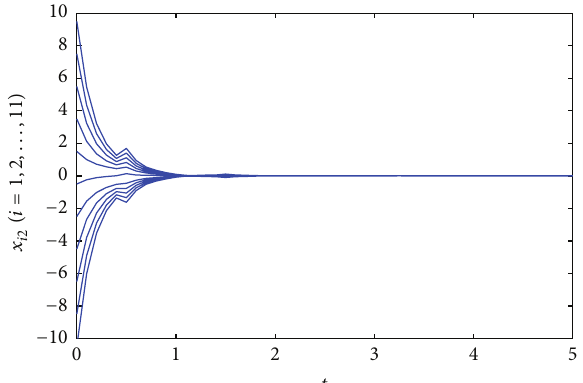
Figure 3: Time response of the state variable 𝑥 2 (𝑡) with impulsive effects.